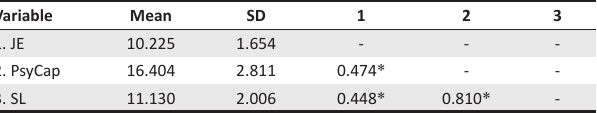
TABLE 3: Descriptive statistics, correlations between job embeddedness and psychological capital and self-leadership ( N = 303). Variable